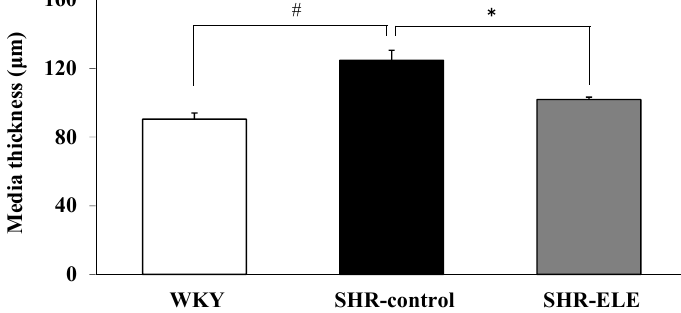
Figure 5. Thoracic aorta ring media thickness in the indicated treatment groups. The values represent the means ± SE; * p < 0.05, as compared with the spontaneously hypertensive rat (SHR)-control group; # p < 0.05, as compared with the Wistar Kyoto rat (WKY) group. ELE, Eucommia leaf extract.